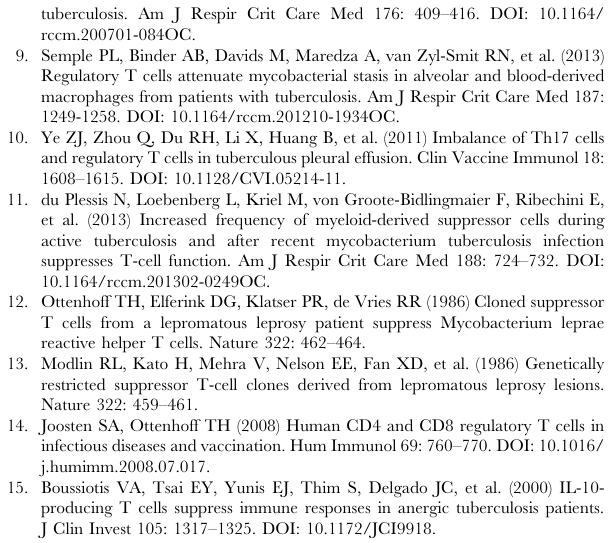
Figure S1 Treg-cell marker expression in samples not stimulated with BCG. Positive populations for Treg-cell markers were defined by comparison with not BCG-stimulated samples for each donor. In the latter samples, only CCL4 expression was significantly higher on CD8 + T cells, compared to CD4 + T cells. (TIF) Figure S2 CD8 + : CD4 + ratio after expansion of T-cell lines. Heatkilled and live BCG-activated T cell-lines were expanded and CD4 + and CD8 + frequencies were assessed by flowcytometry. The median pre-expansion CD8 + : CD4 + ratio was